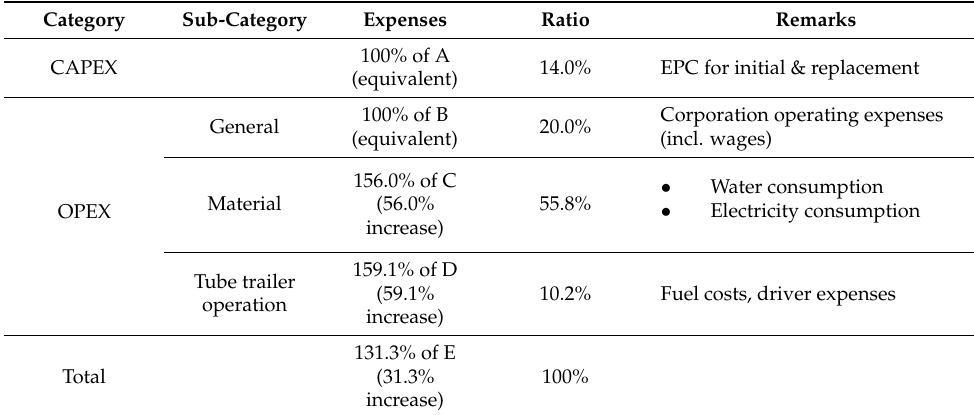
Table 39. Estimation of whole expenses and breakdown (Scenario VI).